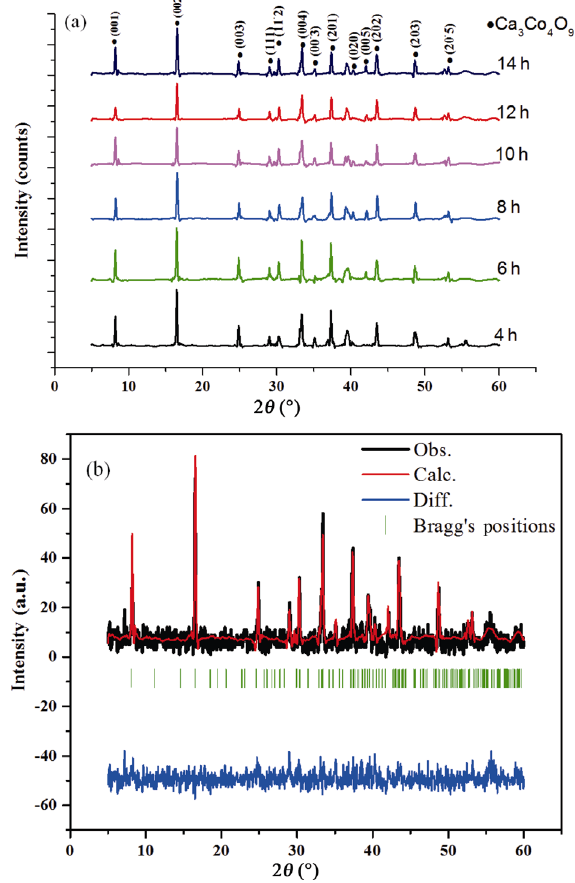
Fig. 6 (a) XRD patterns of pure Ca 3 Co 4 O 9 powder calcinated at 1073 K with different time of 4, 6, 8, 10, 12, and 14 h. (b) Rietveld refined XRD pattern of Ca 3 Co 4 O 9 for 12 h sample.